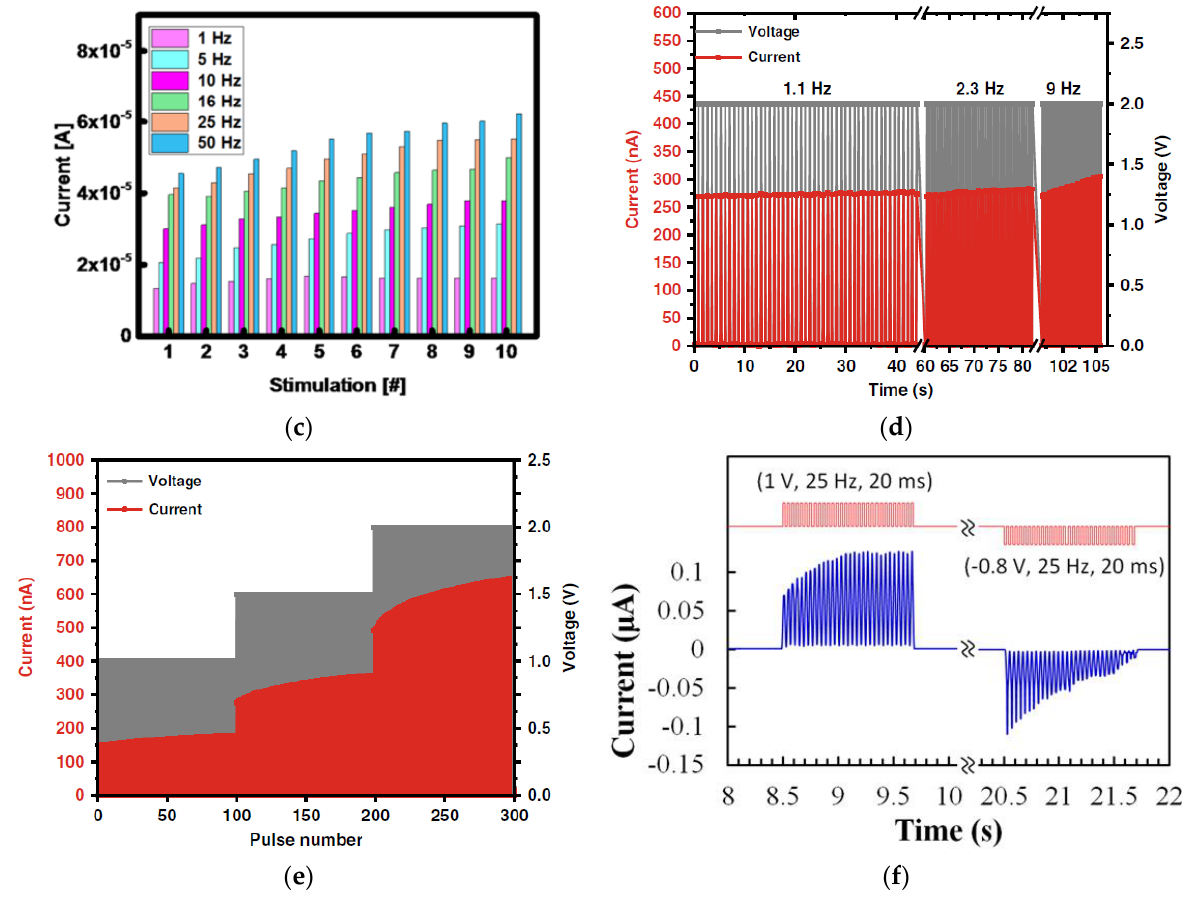
Figure 10. SRDP test results on various biomaterials-based synaptic devices, ( a ) cellu- lose-memristor [54], ( b ) chitosan-transistor [5], ( c ) collagen-memristor [25], ( d , e ) chi- tosan-memristor [3], and ( f ) honey-memristor